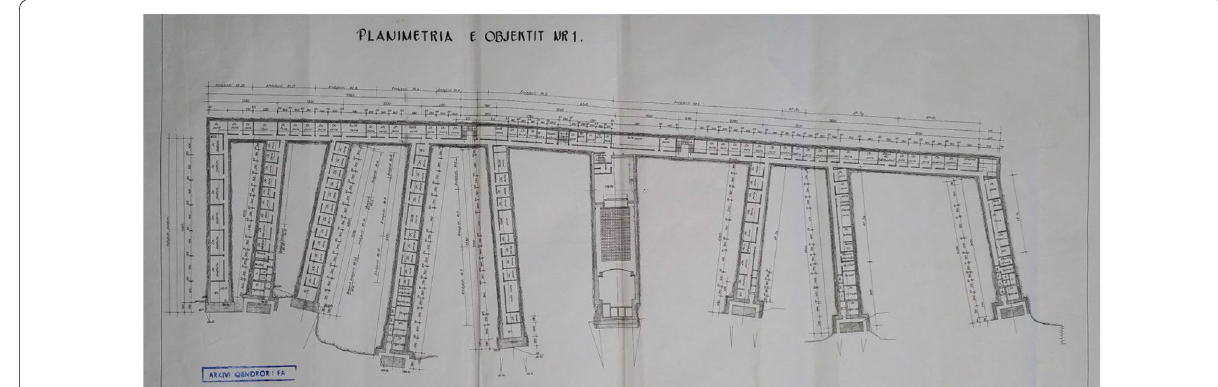
Fig. 5 Plan of existing tunnel condition of Bunkart 1